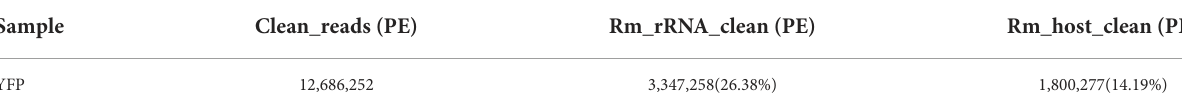
TABLE 2 Statistical analysis of the sequence information after removing host